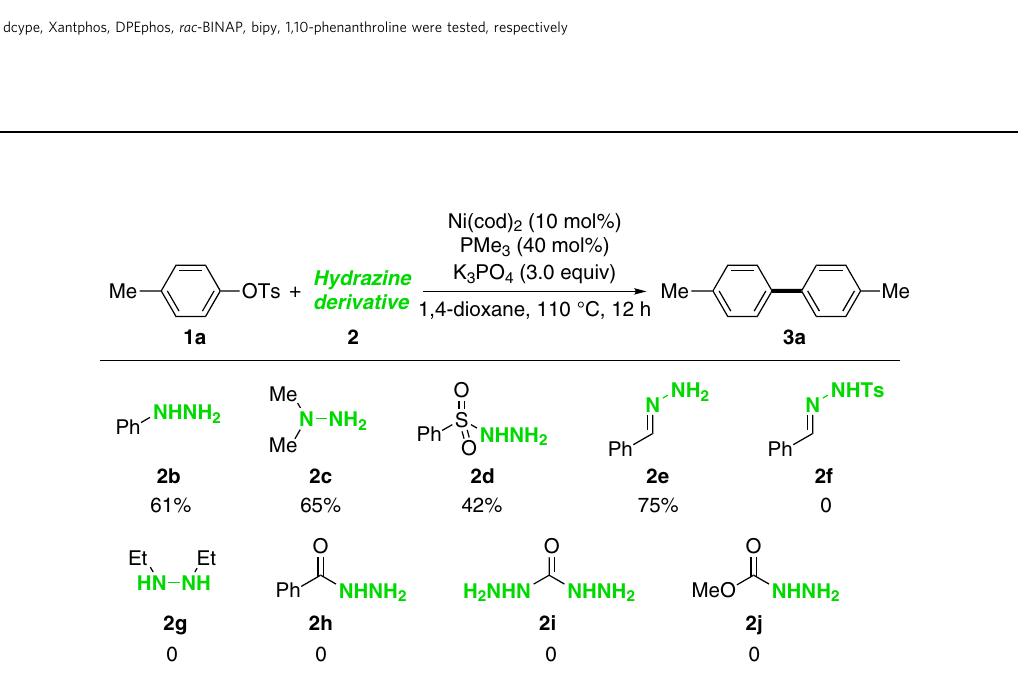
NATURE COMMUNICATIONS| (2018) 9:4739 |DOI: